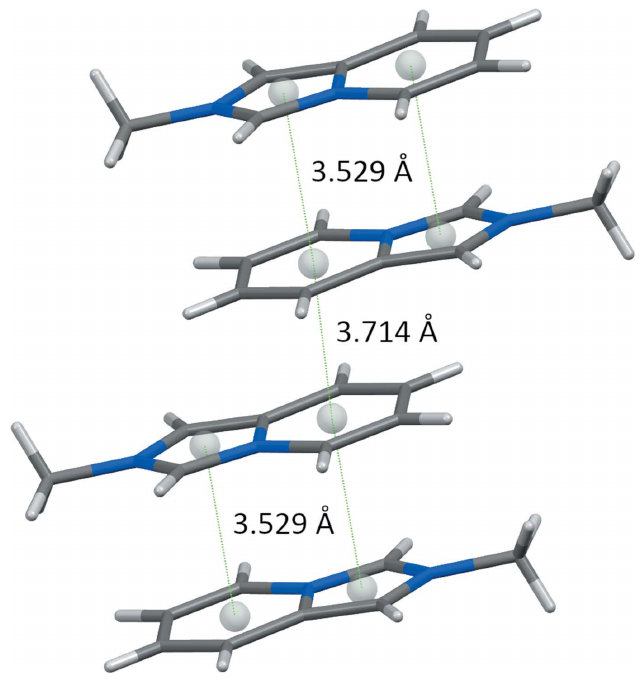
Figure 3 Fragment of the (cid:2) -stacked chain built of pairs of L + cations of